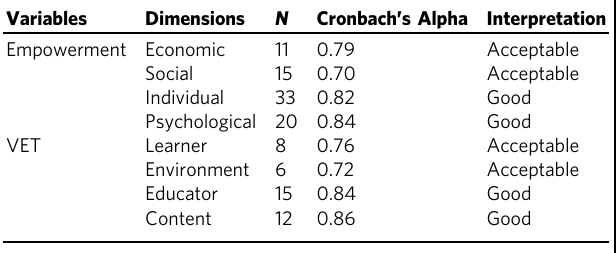
Table 2 Cronbach ’ s alpha values of the research variables. Table 3 The frequency distribution of rural women in terms